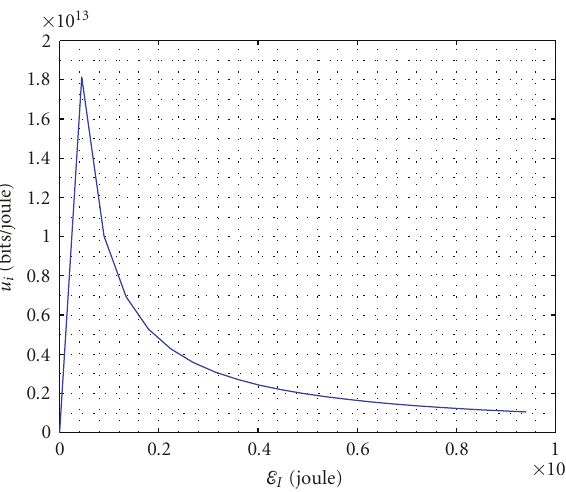
Figure 9: Utility as a function of energy required for cooperative transmission of information bearing